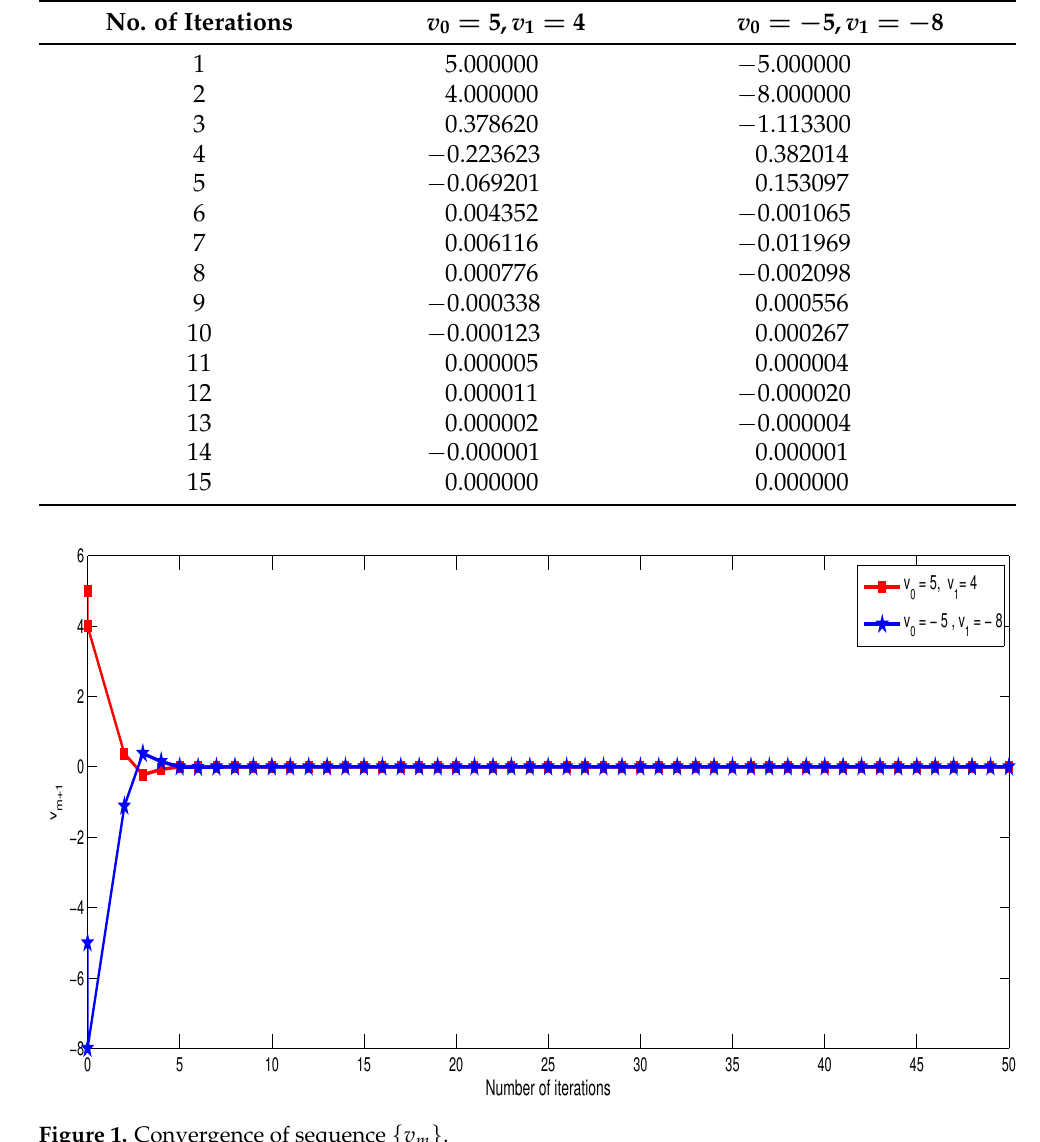
Figure 1. Convergence of sequence { v m }